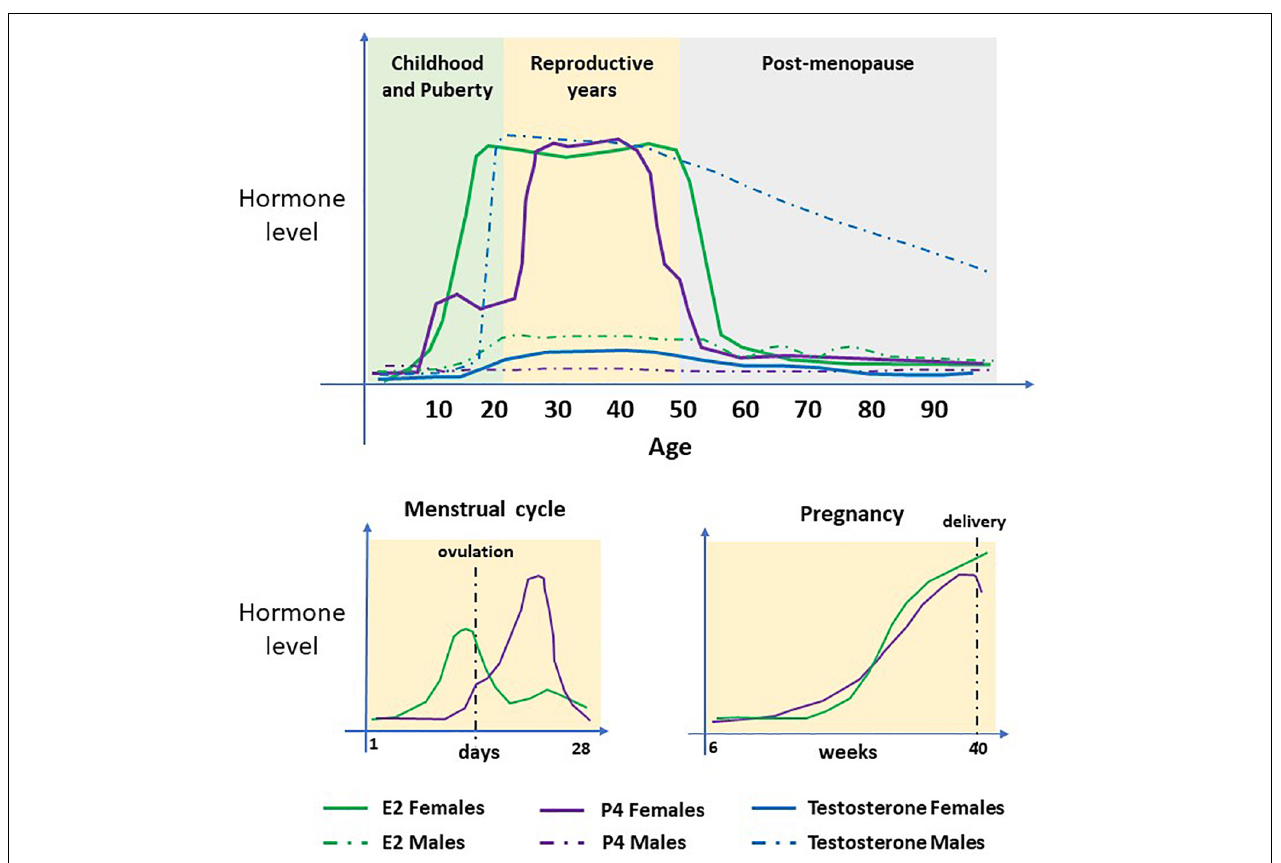
FIGURE 4 | Serum concentrations of sex steroid hormones. The hormones 17 β -estradiol (E2), Progesterone (P4) and Testosterone (T/DHT) in women and men during their life course. In females, E2 and P4 are the predominant hormones. Concentrations increase at puberty, undergo cyclical changes during the menstrual cycle and steadily increase during pregnancy. At menopause, concentrations decline to pre-puberty levels. T/DHT is the predominant male hormone which increases at puberty and remains high until late in life when levels decline steadily.